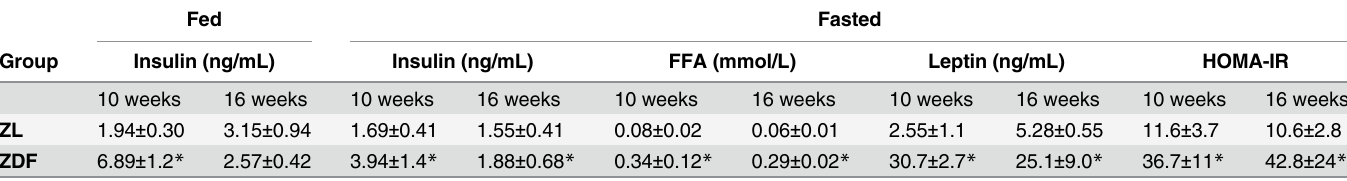
Table 1. Plasma Insulin, FFA, Leptin, and HOMA-IR Measurements.